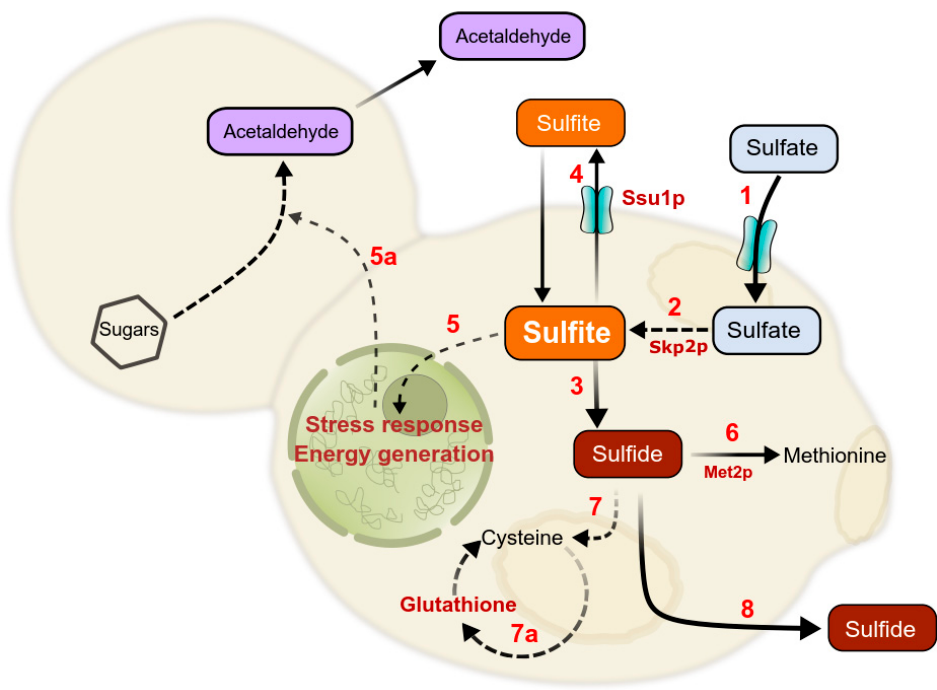
Figure 1. Simplified overview of sulfite-related pathways. (1) Extracellular sulfate is transported into the cell through the sulfate permease. (2) After activation by adenylation, sulfate is reduced to sulfite by the activity of different enzymes coded by MET3 , MET14 , and MET16 ; SKP2 affects the activity of MET14 . (3) Sulfite is further reduced to sulfide by the sulfite reductase enzyme. (4) Sulfite is transported outside the cells by the sulfite transporter Ssu1p. (5) Sulfite triggers multiple stress responses in the cells, among which (5a) an increased acetaldehyde production. Sulfide is incorporate directly into methionine (6) and indirectly (7) into cysteine. MET2 influences the availability of O-acetylhomoserine, required to synthesize methionine. (7a) Glutathione is formed through the reaction of cysteine with glutamate and glycine. (8) Excess sulfide diffuses from the inside to the outside of the cell.